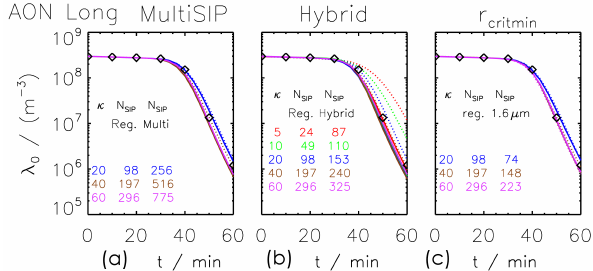
Figure 19. Droplet number as a function of time obtained by AON for the Long kernel. The black symbols show the moments of the reference solution. In each panel, the dotted curves depict the re- sults with the regular singleSIP-init as already shown in column 2 of Fig. 18. The solid curves depict results with a modified ini- tialisation: the right panel shows results with the multiSIP-init, the middle column with the hybrid init and the right column with the Figure 18. Moments λ 0 and λ 2 as a function of time obtained by singleSIP-init with r critmin 1 . 6µm. Each panel shows results for = AON for the Long kernel. The black diamonds show the reference various κ values (see corresponding legend). The hybrid version solution. The curves depict the AON results (averages over 50 re- uses κ 100 for radii above 15µm and κ as labelled for radii below = alisations). The default settings are probabilistic singleSIP-init with 15µm. The multiSIP-init and hybrid version use more SIPs than the weak threshold η 10 − 9 , κ 40 and (cid:49)t 10s. The left column regular singleSIP-init. An r critmin increase leads to a N SIP reduction = = = shows a variation of (cid:49)t (see legend) for the regular AON version (see listed N SIP values in the plots for a (solid) and for a version disregarding multiple collections (dotted, only cases with (cid:49)t 20s are displayed). The middle column shows ≤ a variation of κ (see legend). The right column displays simula- tions with various initialisation techniques: the ν const -init (solid) and ν draw -init (dotted) with various N SIP values (see legend) as well as the ν random , rs -init (green dashed) and ν random , lb -init (green dash- dotted).